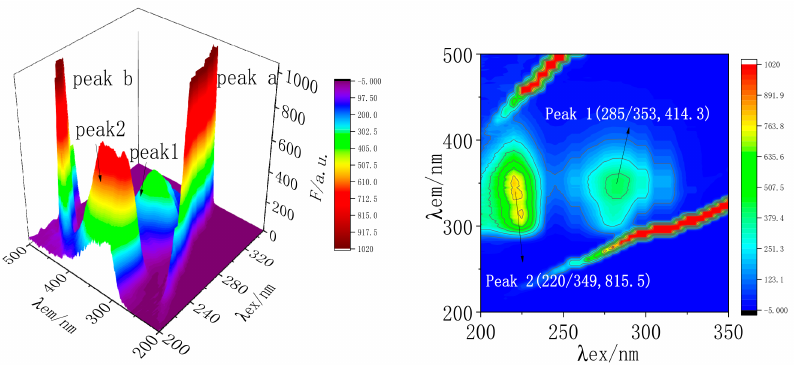
Figure 8. Three-dimensional fluorescence spectra and contour maps of TRP. C (TRP) = 1.5 × 10 − 7 mol/L; T = 298 K; pH = 7.40.